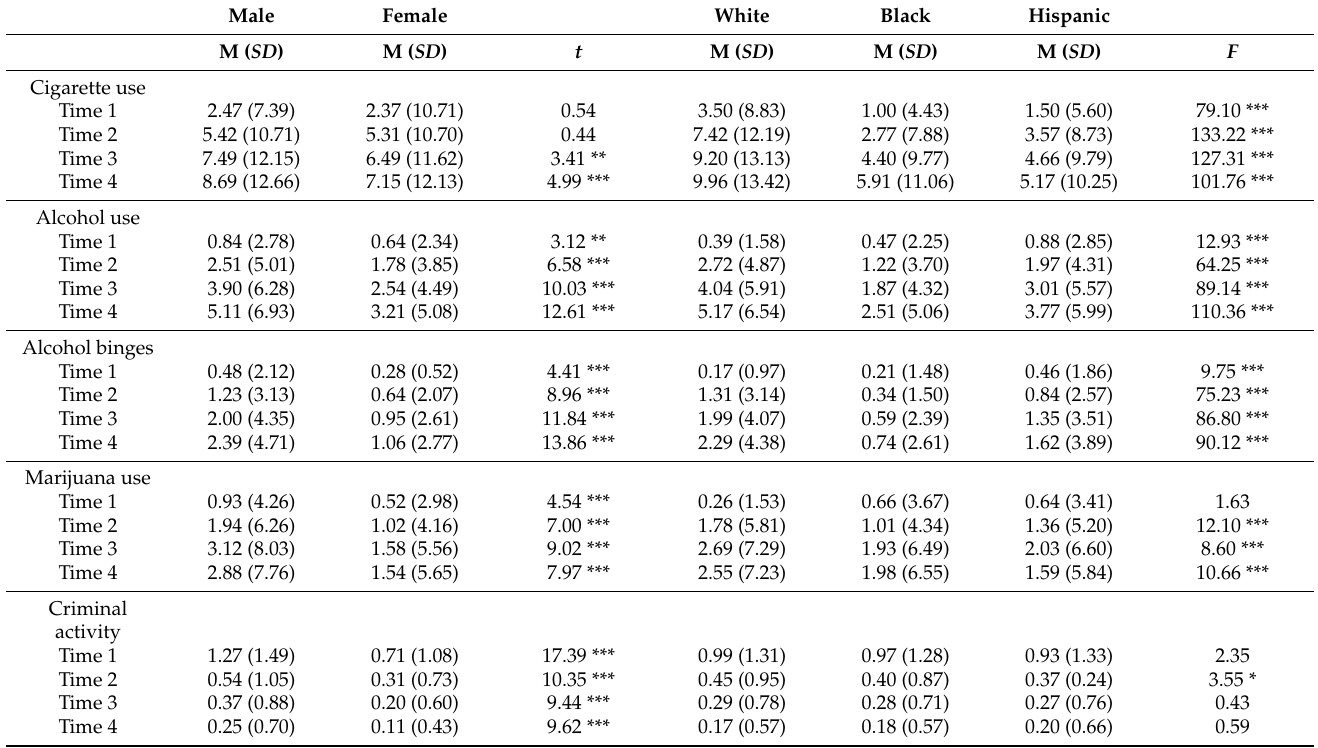
Table 2. Descriptive statistics for substance use and criminal activity over time across gender and